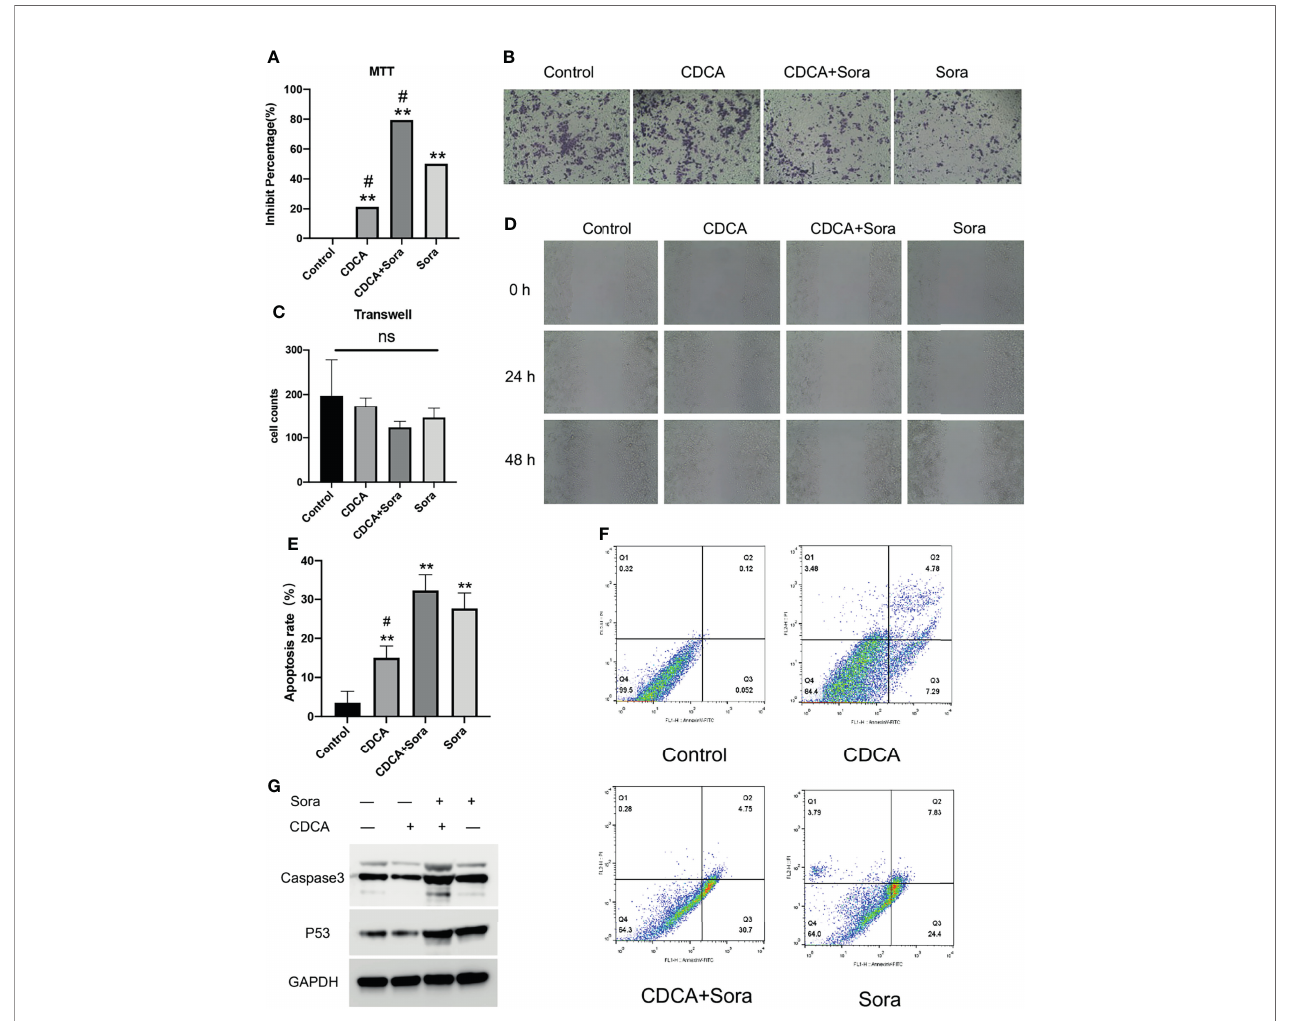
FIGURE 1 | CDCA inhibits cells in vitro in synergy with sorafenib. HepG2 cells were treated with 10 m M sorafenib, 1 m g/mL CDCA, or 1 m g/mL CDCA plus 10 m M sorafenib for 24 hours. (A) MTT assay of cell proliferation in all treatment groups. ** P < 0.01 vs. control group, # P < 0.05 vs. sorafenib group. (B) Crystalline violet staining to observe cell proliferation (20x). (C) Transwell assays revealed no signi fi cant difference between the groups. ns, no signi fi cance. (D) Representative images of scratch assay results at 0, 24, and 48 h (10x). (E) Apoptosis rates in all treatment groups. ** P < 0.01 vs. control group, # P < 0.05 vs. sorafenib group. (F) Flow- cytometric detection of apoptosis in all treatment groups. (G) Western blot detection of cell supernatant caspase 3 and p53 expression